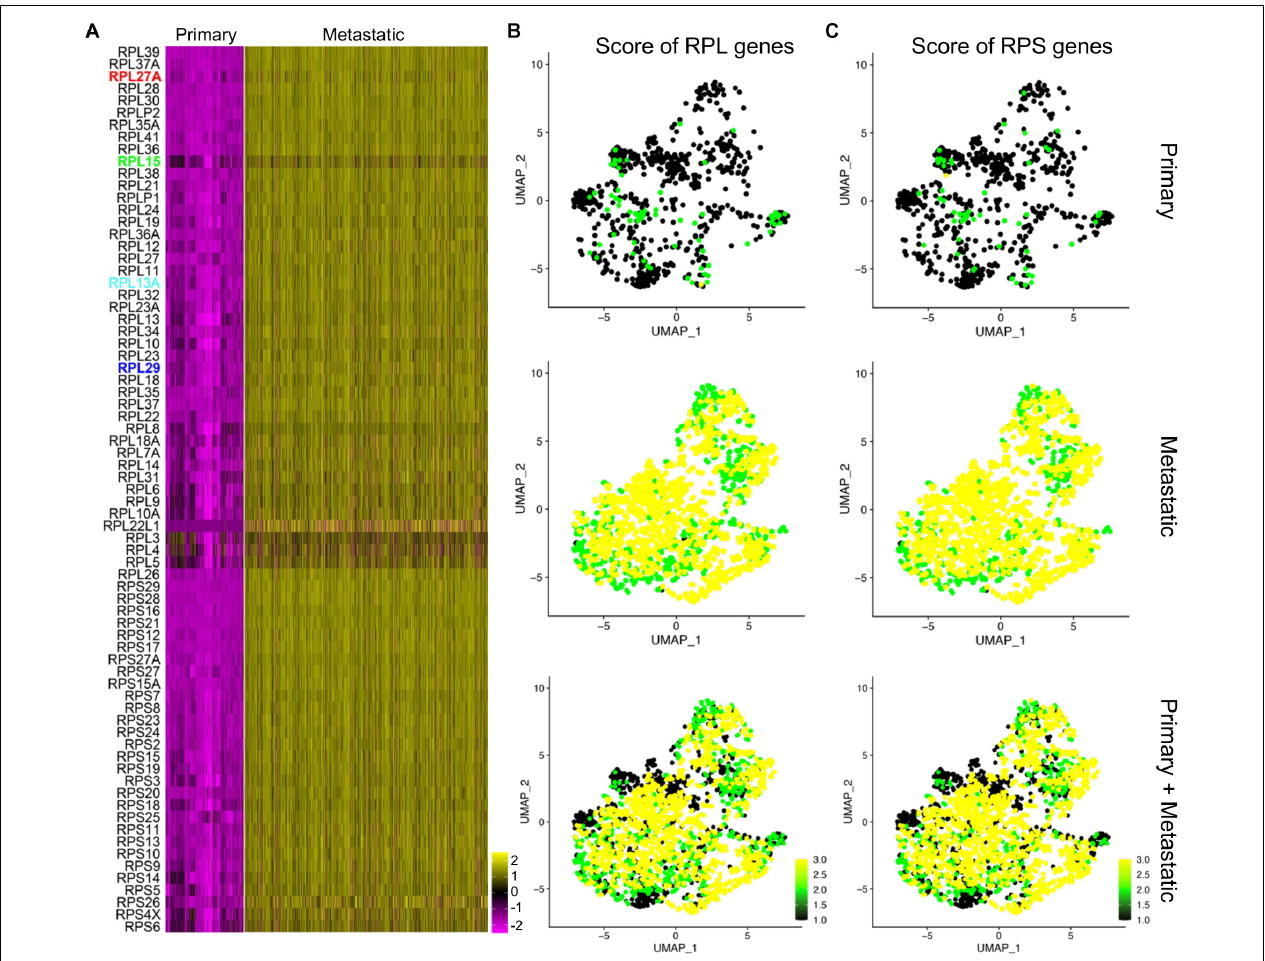
FIGURE 6 | Deregulated ribosome protein genes in metastatic cancer cells. (A) Heatmap visualization of the expression of upregulated ribosome protein genes in the primary and metastatic cancer cells. (B,C) Scores of the RPL genes (B) and RPS genes (C) in primary, metastatic, and integrated